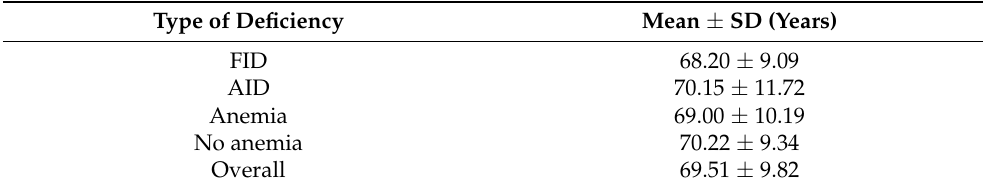
Table 1. Mean age of patients according to type of iron